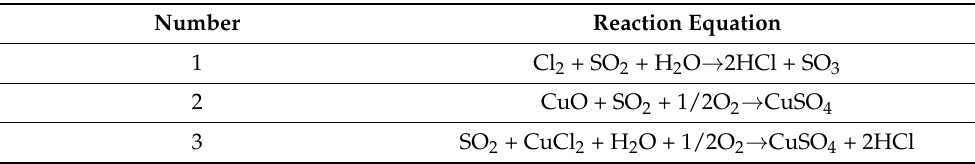
Table 7. Reaction of sulfur with key elements in the synthesis of